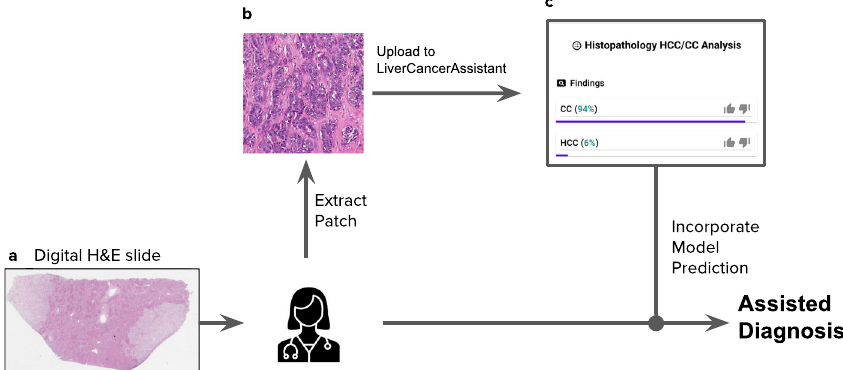
Fig. 3 Pathologist diagnostic work fl ow with assistance. After reviewing the H&E whole-slide image ( a ), the pathologist extracts a tumor patch at ×10 objective magni fi cation ( b ) and uploads it to the cloud-based model, which outputs predicted probabilities for cholangiocarcinoma (CC) and hepatocellular carcinoma (HCC) into the user interface ( c ), as well as corresponding class activation maps (not shown). These outputs are integrated with the pathologist ’ s diagnostic impression, to result in a fi nal assisted